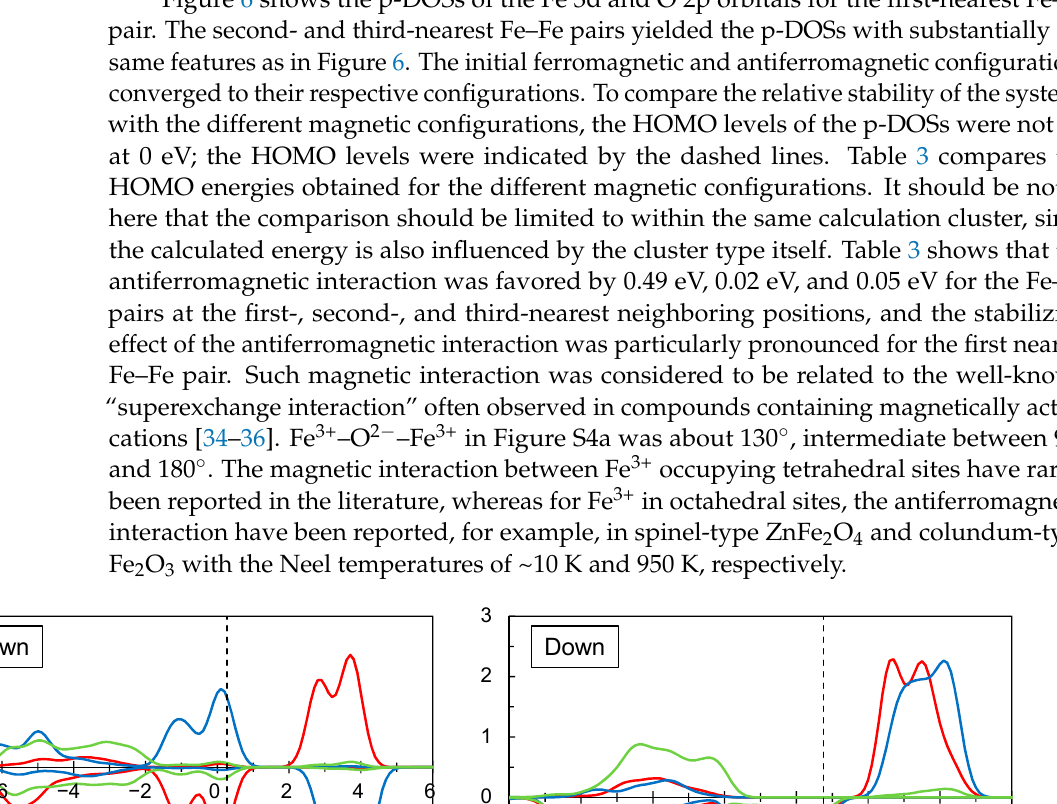
Figure 5. Frequency distribution of Al atoms around Al in γ -LiAlO 2 :Fe 3+ . The arrows indicate the Fe–Fe distances observed in the relaxed structures after MD.